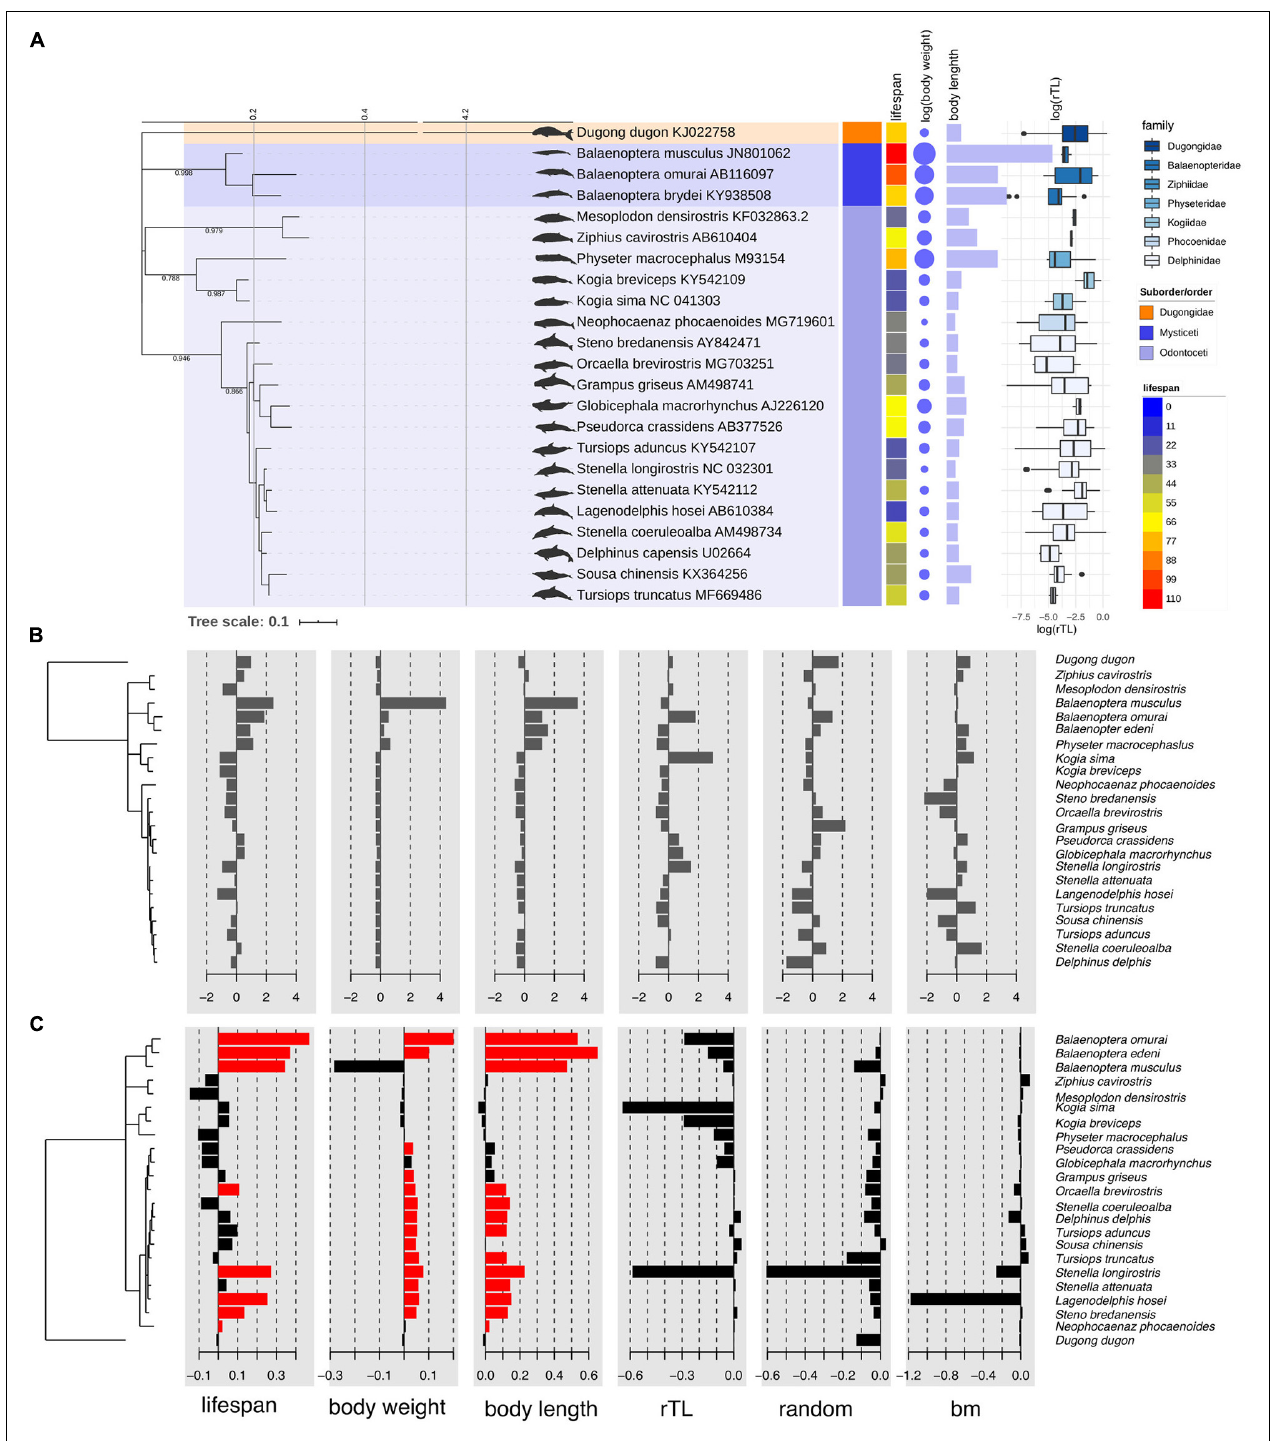
FIGURE 1 | Phylogenetic tree of marine mammals based on sequences of control regions with information about average lifespan, body weight, body length, and relative telomere length of each species found in Thailand oceans (A) . Phylogenetic tree with value of each trait centered and scaled (B) and with Local Moran’s index ( I i ) values for each species for traits including lifespan, body weight, body length, relative telomere length (rTL), random dataset, and Brownian Motion (BM) dataset (C) . The red bar indicates the significant I i values at p < 0.05. The phylogeny was built based on 220 pb control region of 22 cetacean species under GTR + (cid:48) through Bayesian inference. Dugong was